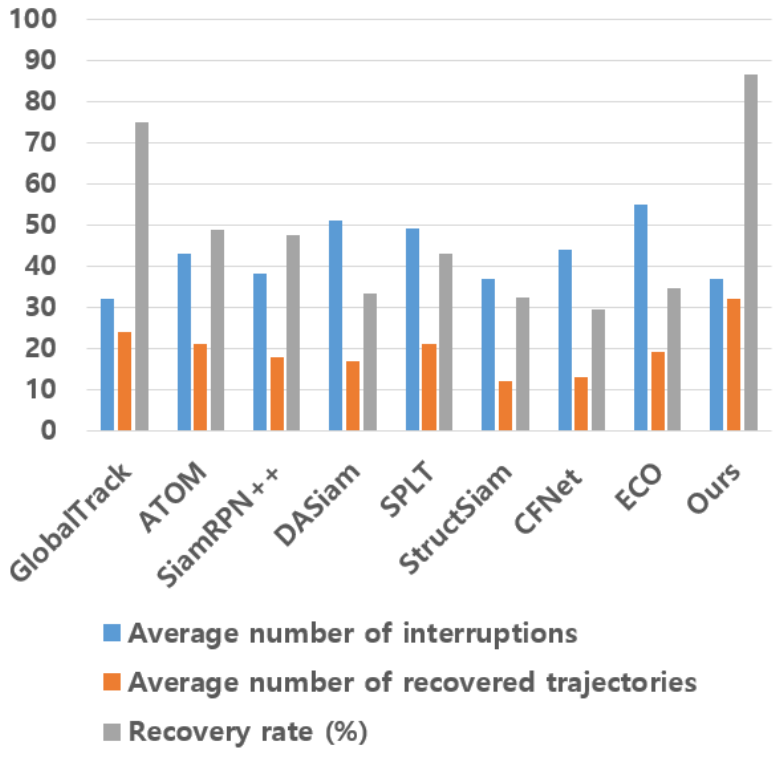
Figure 6. Comparison on the recovery rate. Blue, orange, and gray bars denote the average number of interruptions, the average number of recovered trajectories, and recovery rate × 100), (i.e., average number of recovered trajectories average number of interruptions